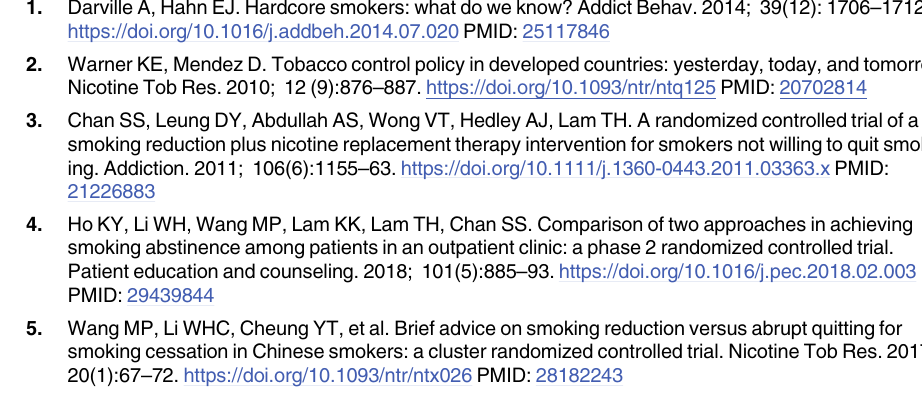
S1 Fig. Calculation formula of the standardized difference for continuous variables. (TIF) S2 Fig. Calculation formula of the standardized difference for dichotomous variables. (TIF) S1 Table. Comparison of baseline characteristics and smoking profiles among subjects in the QP group and control group in the original unmatched sample and the propensity- score matched sample. S2 Table. Cessation outcomes of subjects in the QP group vs. control group original trial protocol and statistical analysis